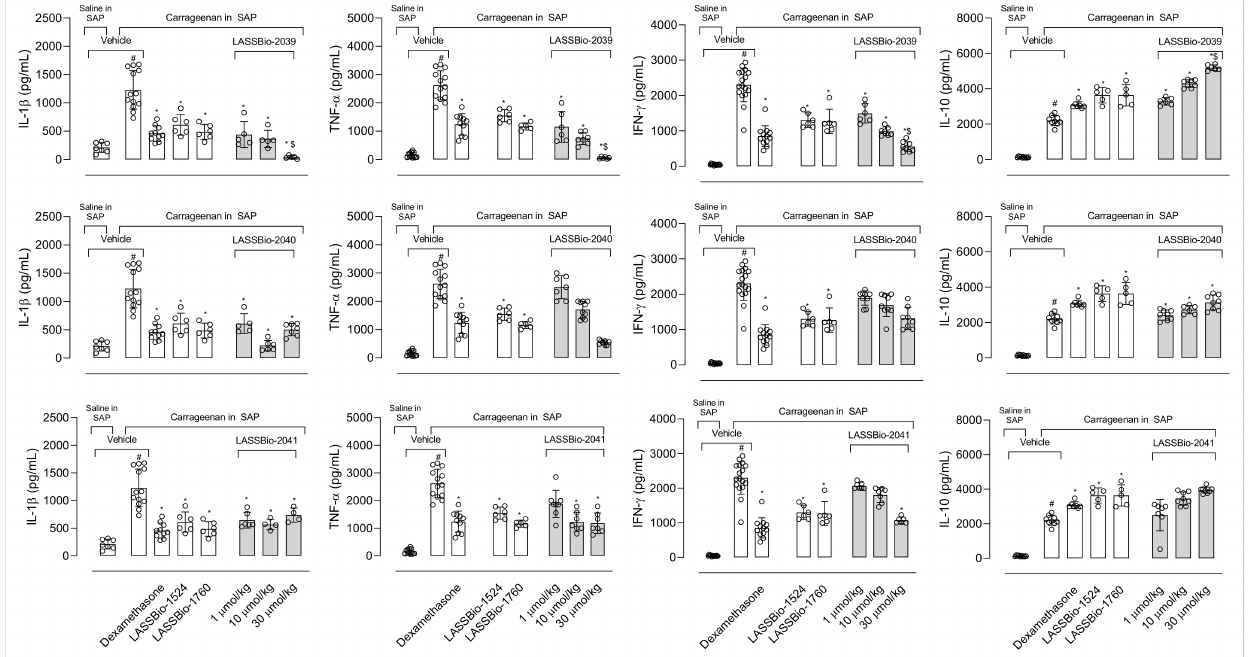
Figure 6. LASSBios reduce interleukin-1 β (IL-1 β ), tumor necrosis factor- α (TNF- α ), interferon- γ (IFN- γ ) and increase interleukin-10 (IL-10) produced in the inflammatory exudate. Animals were pre- treated with vehicle, LASSBio-1524 or LASSBio-1760 (at 30 µ mol/kg), dexamethasone (6.5 µ mol/kg) or LASSBios (doses of 1, 10 or 30 µ mol/kg) 1 h before injection of saline (NaCl 0.9%) or carrageenan into the SAP. Results are expressed as media ± SD ( n = 5–12). Where no error bar is shown it is because it is smaller than the symbol. Statistical significance was calculated in GraphPad Prism 8.0 (San Diego, CA, USA) using analyses of variance (ANOVA) followed by Tukey post-test with p < 0.01 (#) when comparing vehicle-treated group that received carrageenan injection into the SAP with vehicle-treated group that receives saline into the SAP. p < 0.01 (*) when comparing dexamethasone- or LASSBios-treated group that received carrageenan injection into the SAP with vehicle-treated group that receives carrageenan into the SAP. p < 0.01 ($) when comparing LASSBio- 2039-treated group that received carrageenan injection into the SAP with LASSBio-1760-treated group that receives carrageenan into the SAP. Data for the original compounds (LASSBio-1524 and LASSBio- 1760) are original, independent duplicates of past results and have not been published